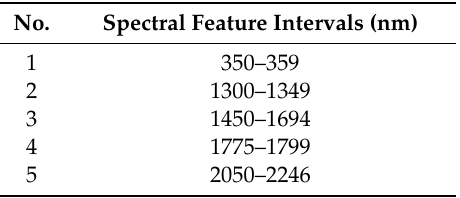
Table 4. Spectral feature filtering experimental